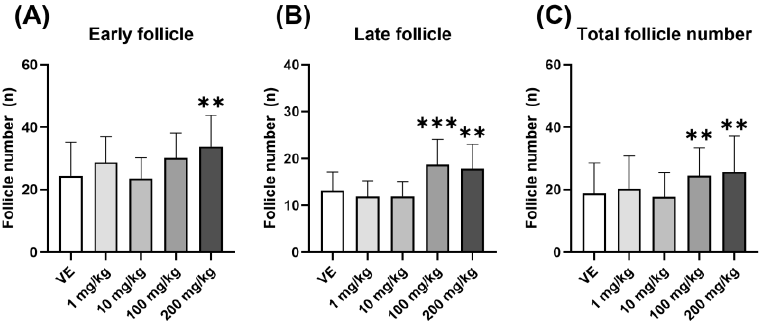
Figure 2. Number of follicles in the ovary of rats exposed to D5. The comparison of the number of ovary follicles in the two stages and the total number of ovary follicles were confirmed: ( A ) number of early follicles including primordial follicle, primary follicle, and secondary follicle; ( B ) number of late follicles including antral follicle and preovulation follicle; ( C ) the total number of follicles including early follicle and late follicle. The values are expressed as means ± SD. ** p < 0.01 and *** p < 0.001 vs. vehicle. VE—vehicle, N = 9~10.